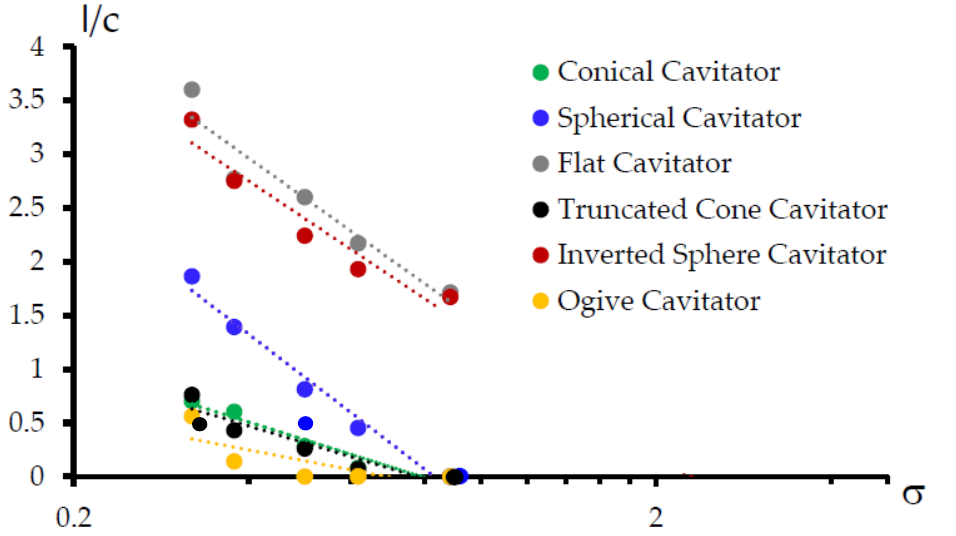
Figure 6. The bubble length (in multiplies of body diameter) vs. the cavitation number for the six cavitators.